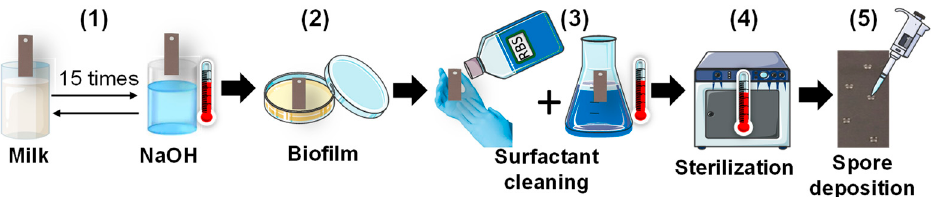
Figure 8. Different steps of stainless-steel plate surface preparation methodology: ( 1 ) 15 cycles of immersion of the plate in milk at room temperature for 30 min and in sodium hydroxide at 70 °C for 30 min; ( 2 ) biofilm formation on the plate; ( 3 ) rubbing of the plate with commercial undiluted surfactant (RBS) followed by immersion of the plate in surfactant aqueous solution at 5 wt.% at 60 °C for 10 min; ( 4 ) the plate sterilization in a hot air oven at 180 °C for 1 h; ( 5 ) soiling of the plate with 5 drops of 1 μ L of the spore suspension at a concentration of 10 8 CFU.mL − 1 .